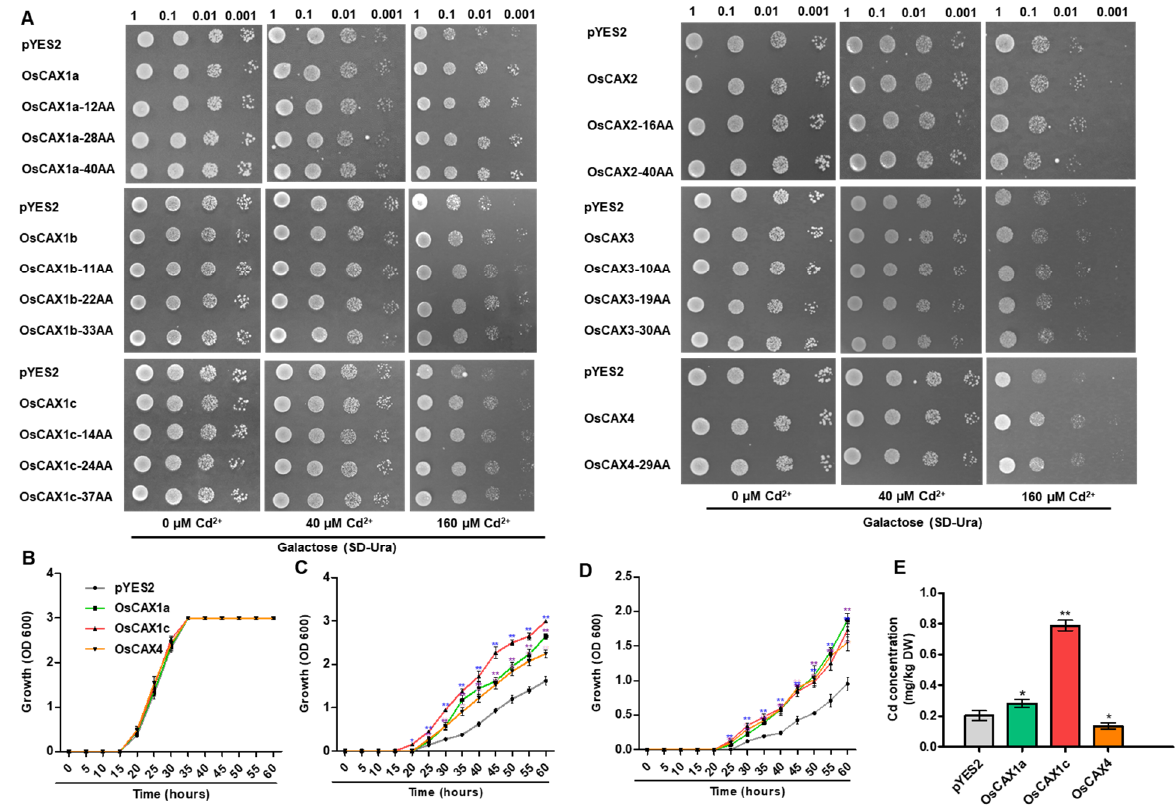
Figure 3. Functional assay of rice CAX genes by heterologous expression in yeast. ( A ) Yeast mutant strain expressing the empty vector pYES2 or vectors for CAX genes grown in SD-Ura medium containing galactose without Cd or with different Cd concentrations. Pictures were taken after 2 days of growth at 30 °C. The growth curve of empty vector, OsCAX1a , OsCAX1c and OsCAX4 transformed yeast BY4741 strain in liquid medium with ( B ) 0, ( C ) 20 or ( D ) 40 μ M CdCl 2 . The absorbance at 600 nm (OD600) of cell cultures was measured every 5 h. ( E ) Cd accumulation in the wild-type BY4741 (gray) and BY4741 expressing OsCAX1a (green), OsCAX1C (red) and OsCAX4 (orange) treated with 5 μ M CdCl 2 for 24 h. Statistical comparison was performed by one-side t -test (* p < 0.05 and ** p < 0.01). Error bar indicates standard deviation, and the data are presented as means ± SD ( n = 3).